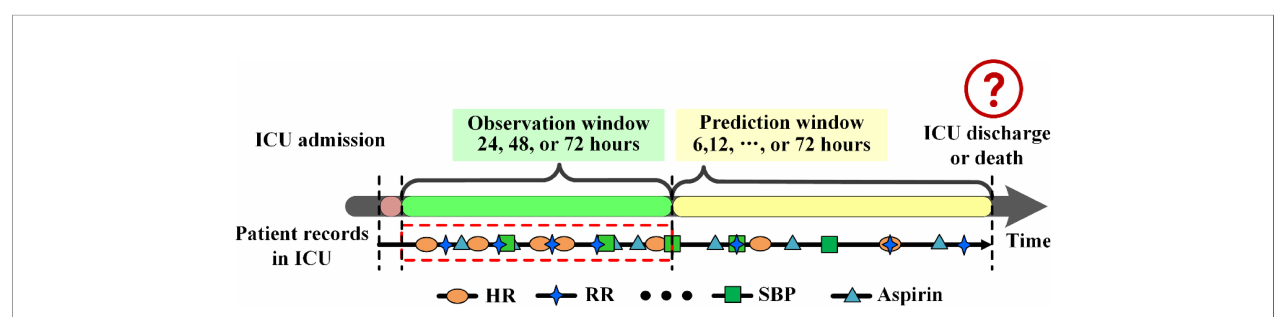
FIGURE 3 | Data extraction framework for pneumonia patients in MIMIC-III. DBP, diastolic blood pressure; HR, heart rate; RR, respiratory rate; SBP, systolic blood